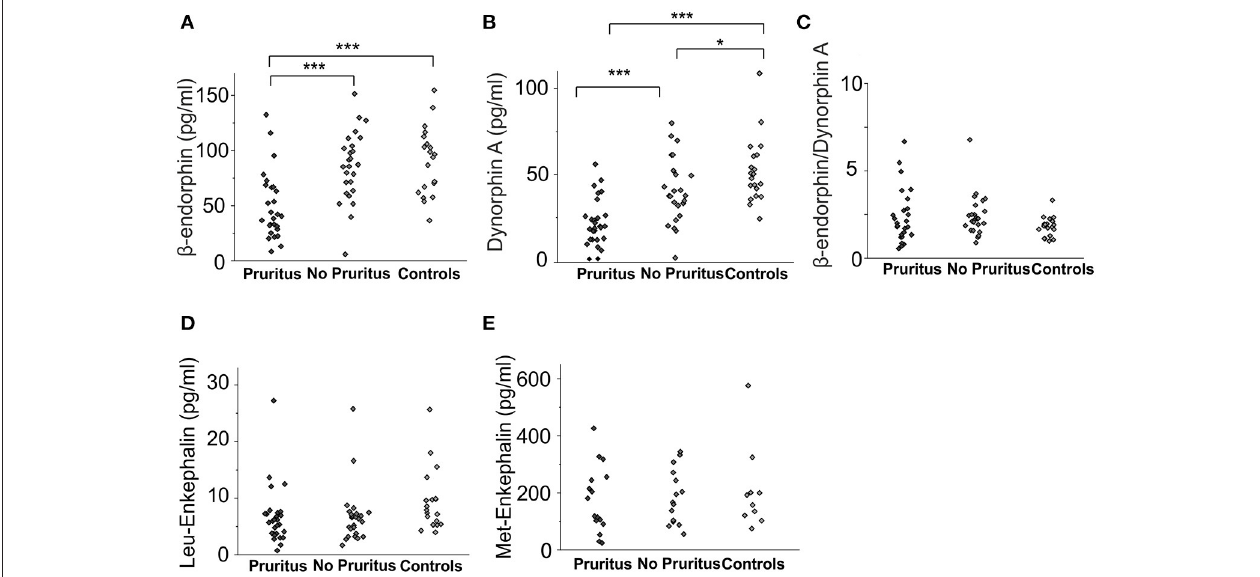
FIGURE 2 | Endogenous opioid plasma levels in patients with cholestatic liver diseases with and without associated pruritus and healthy controls. Concentrations [pg/ml] of β -endorphin (A) and dynorphin A (B) in pruritic patients ( n = 29), non-pruritic patients ( n = 27) and healthy controls ( n = 20) are presented in the respective subfigures. (C) presents the ratio of β -endorphin to dynorphin A levels for all groups (C) . Met-enkephalin and Leu-enkephalin levels in patients with and without pruritus as well as healthy controls are shown in subfigures (D) and (E) . Data were statistically analyzed by multi-way analysis of variance (ANOVA) with least significant difference (LSD) post hoc testing. Significant differences are indicated by asterisks: * p < 0.05, *** p <